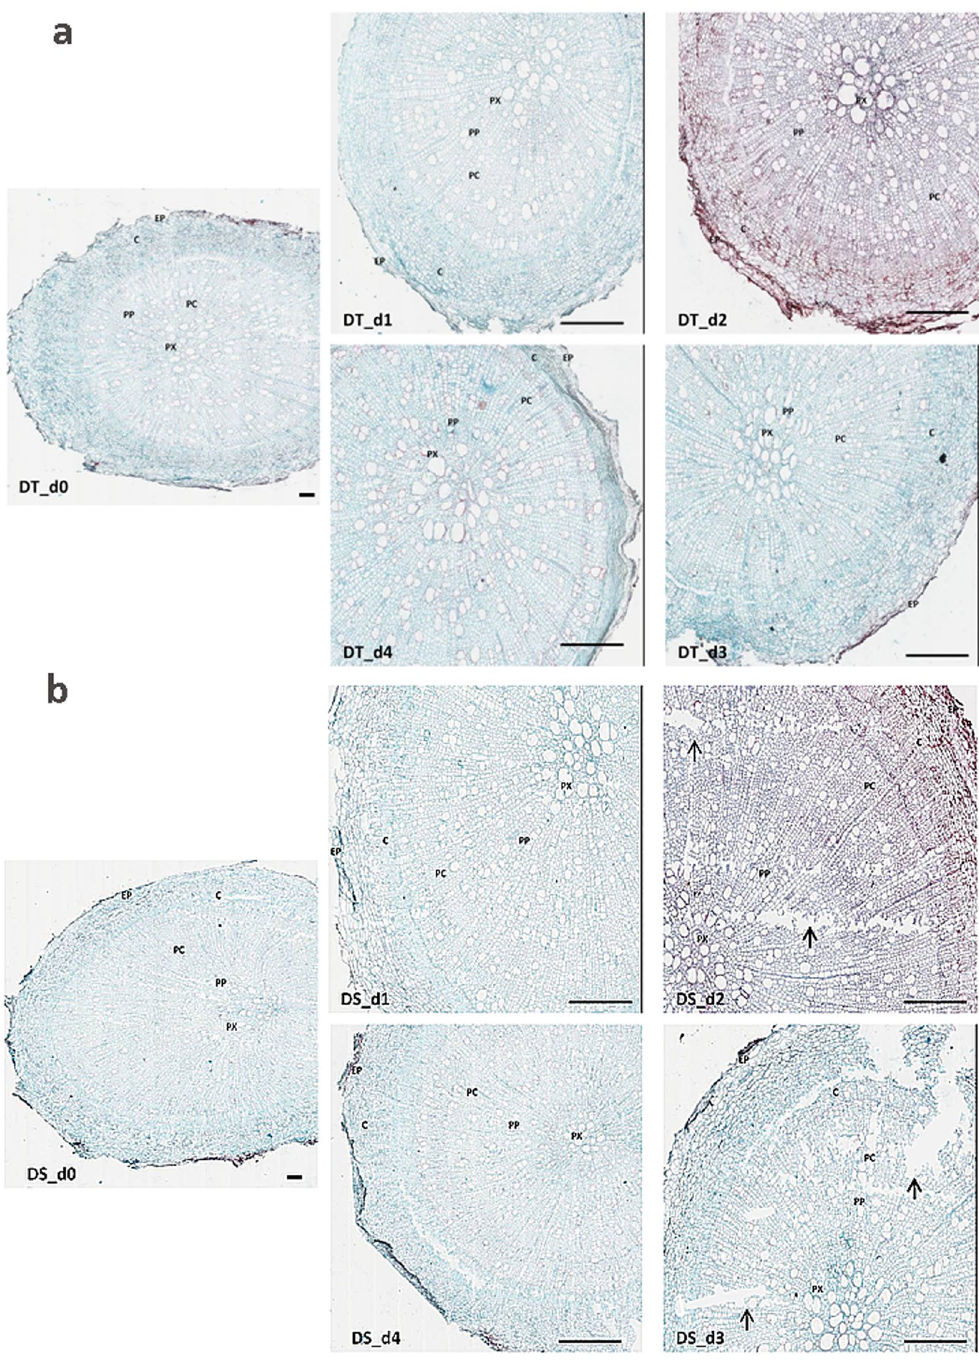
Figure 2. Transverse root sections of ( a ) tolerant (DT) and ( b ) sensitive (DS) sesame genotypes. d 0 , d 1 , d 2 , d 3 and d 4 : root samples from plants stressed for 0, 3, 7, 11 days and 3 days of recovery after rewatering, respectively. Arrows in black indicate damaged cortex. EP: Epidermis; C: Cortex; PC: Parenchyma Cell; PP: Primary Phloem; PX: Primary Xylem. Scale bars = 100 µ